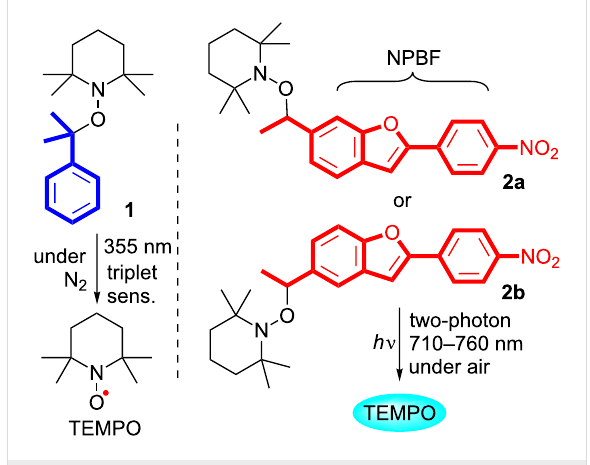
Scheme 1: Photochemical generation of TEMPO